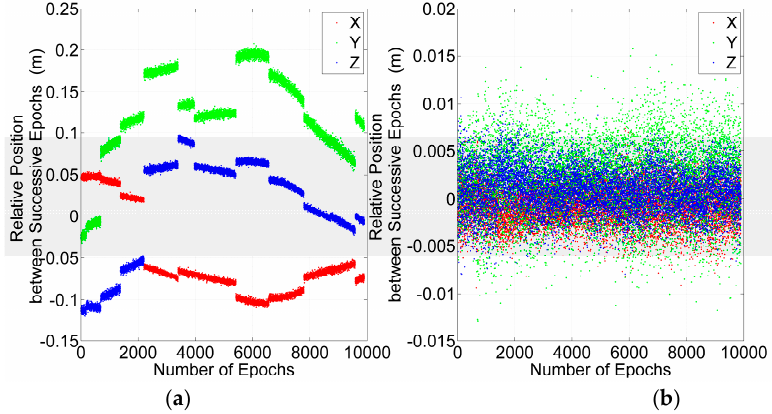
Figure 14. The relative position between successive epochs before ( a ) and after ( b ) cycle slips detection and repair.